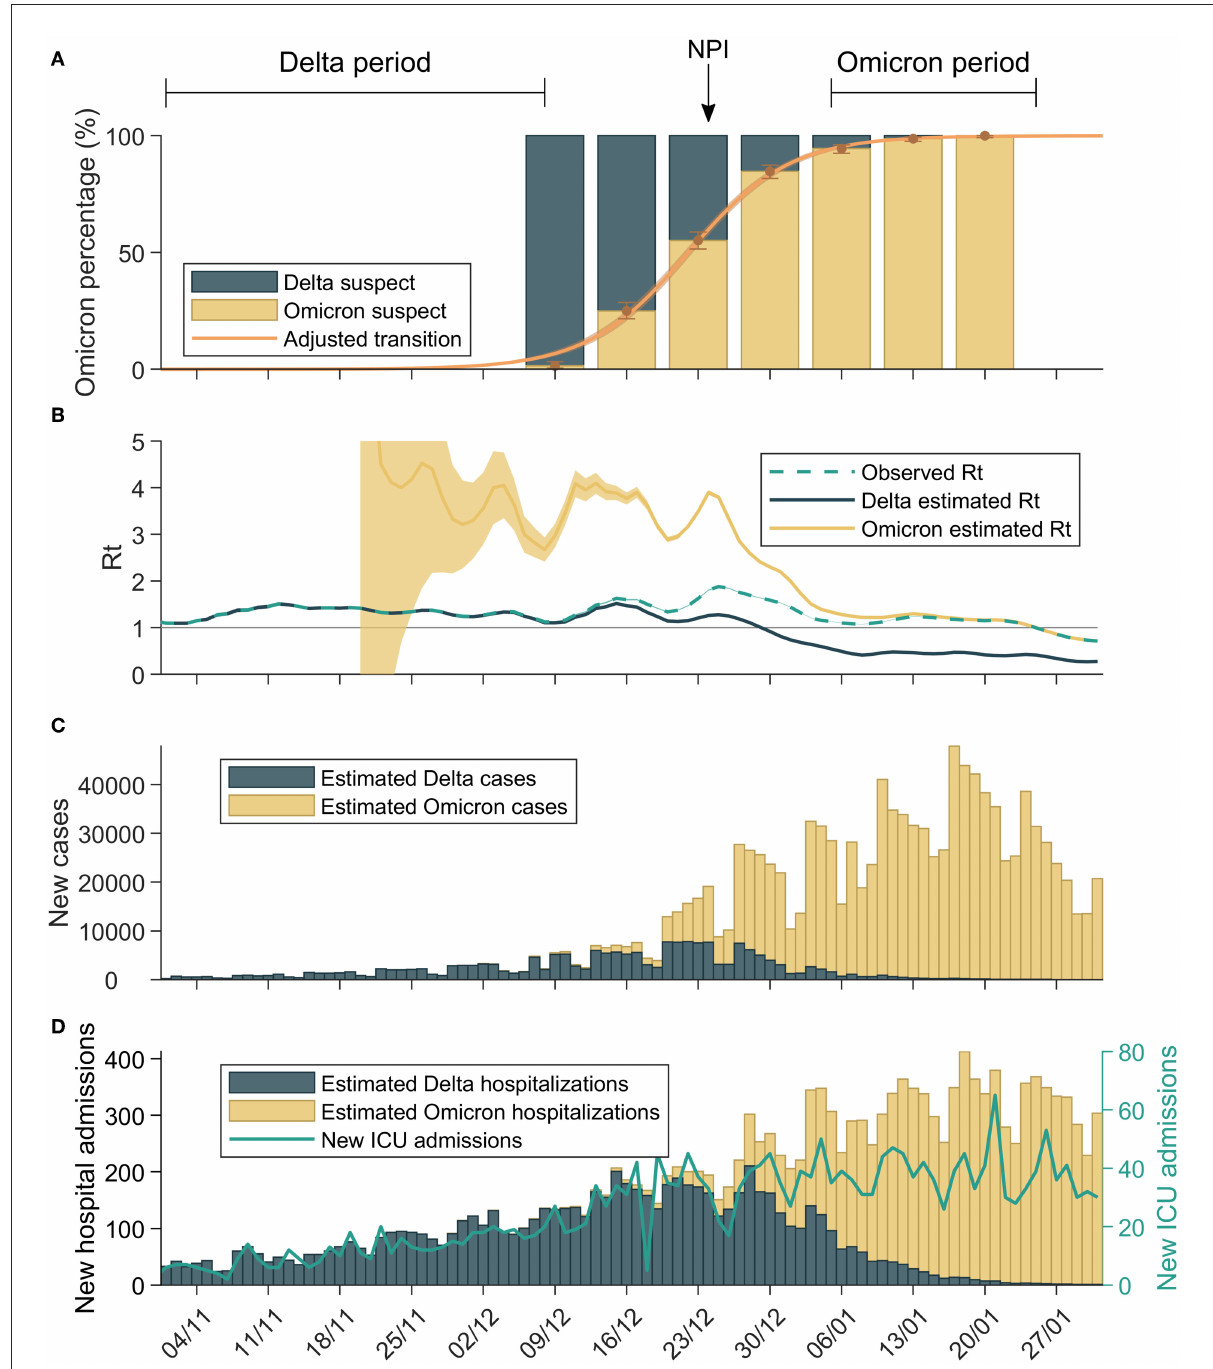
FIGURE1 Omicron emergence in Catalonia. (A) Evolution of the omicron fitted percentage over time, using the substitution model, together with data from PCR screened samples. The two periods considered in the study are also indicated. (B) Empiric reproduction number of population-level incidence, together with the empiric reproduction number estimated for each variant. (C) Daily cases of each variant, estimated with the substitution model fitted to data. (D) Daily hospital admissions of each variant, estimated with the substitution model fitted to data of variants determinations among patients admitted to participant hospitals. The continuous line shows total admissions to intensive care units (variant data not